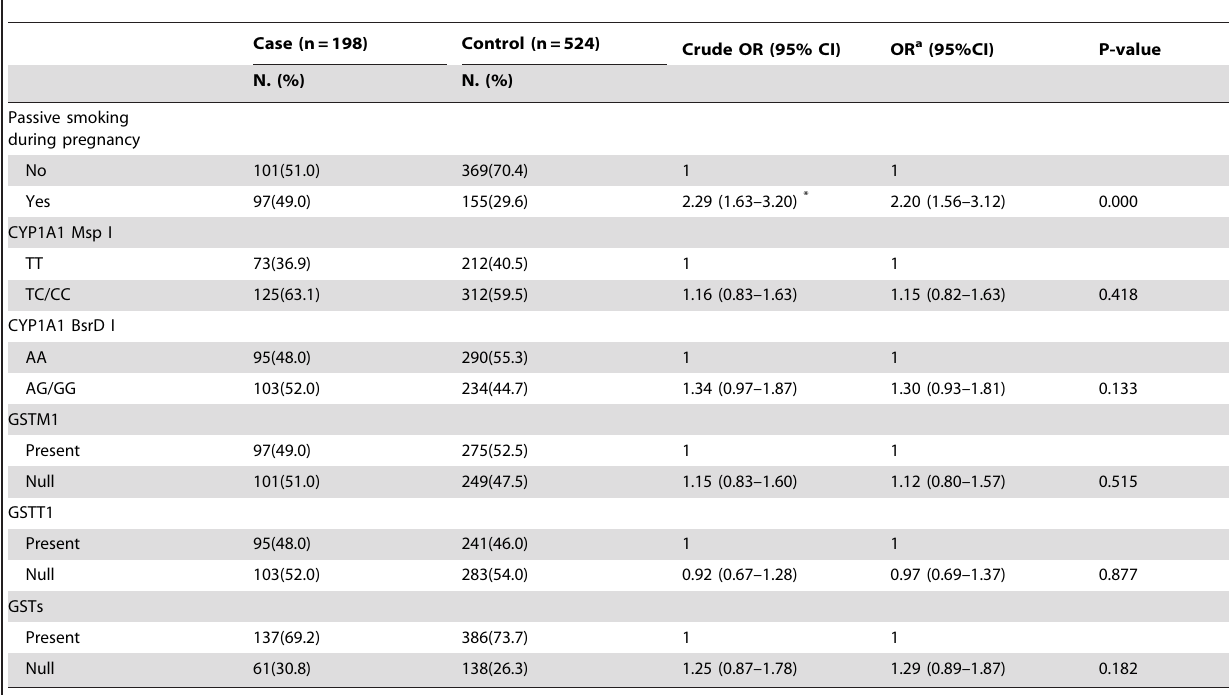
Table 2. Associations of maternal passive smoking during pregnancy, CYP1A1, and GSTs genotypes with risks of spontaneous